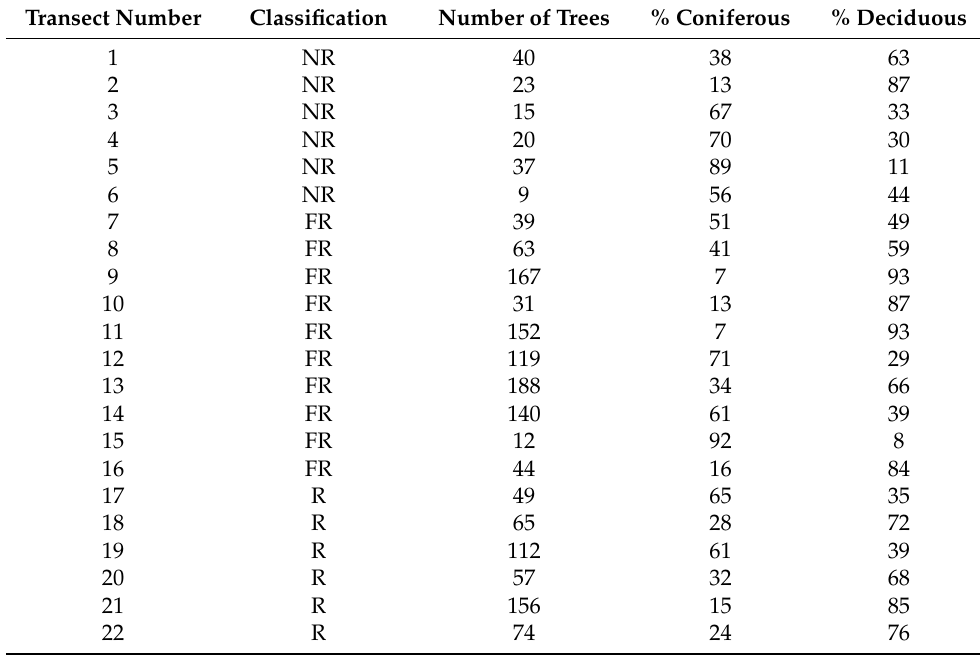
Table A1. Classification and number of trees > 1.5 m measured on each transect. Also percent coniferous and deciduous per transect, and percent of circular plots per